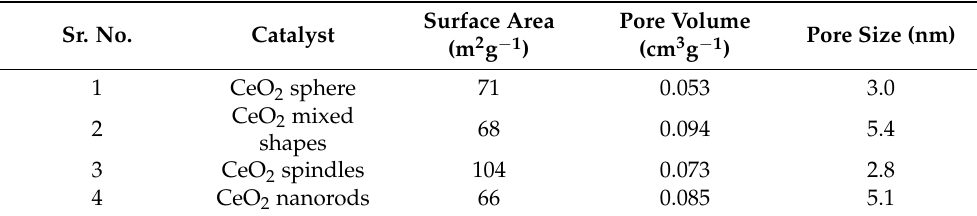
Table 1. Brunauer–Emmett–Teller surface area CeO 2 samples and characteristic FTIR bands of DMC formation on the surface of CeO 2 .